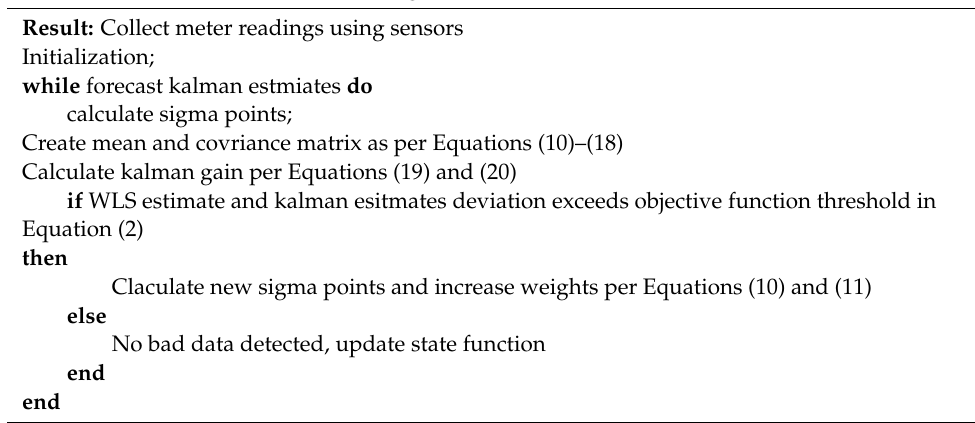
Algorithm 1 Additional estimator using